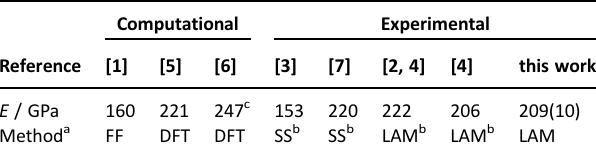
a FF = force field calculation, DFT = density functional theory calcula- tion, SS = stress-strain measurement, LAM = LAM frequency extra- polation; b solid state; c planar